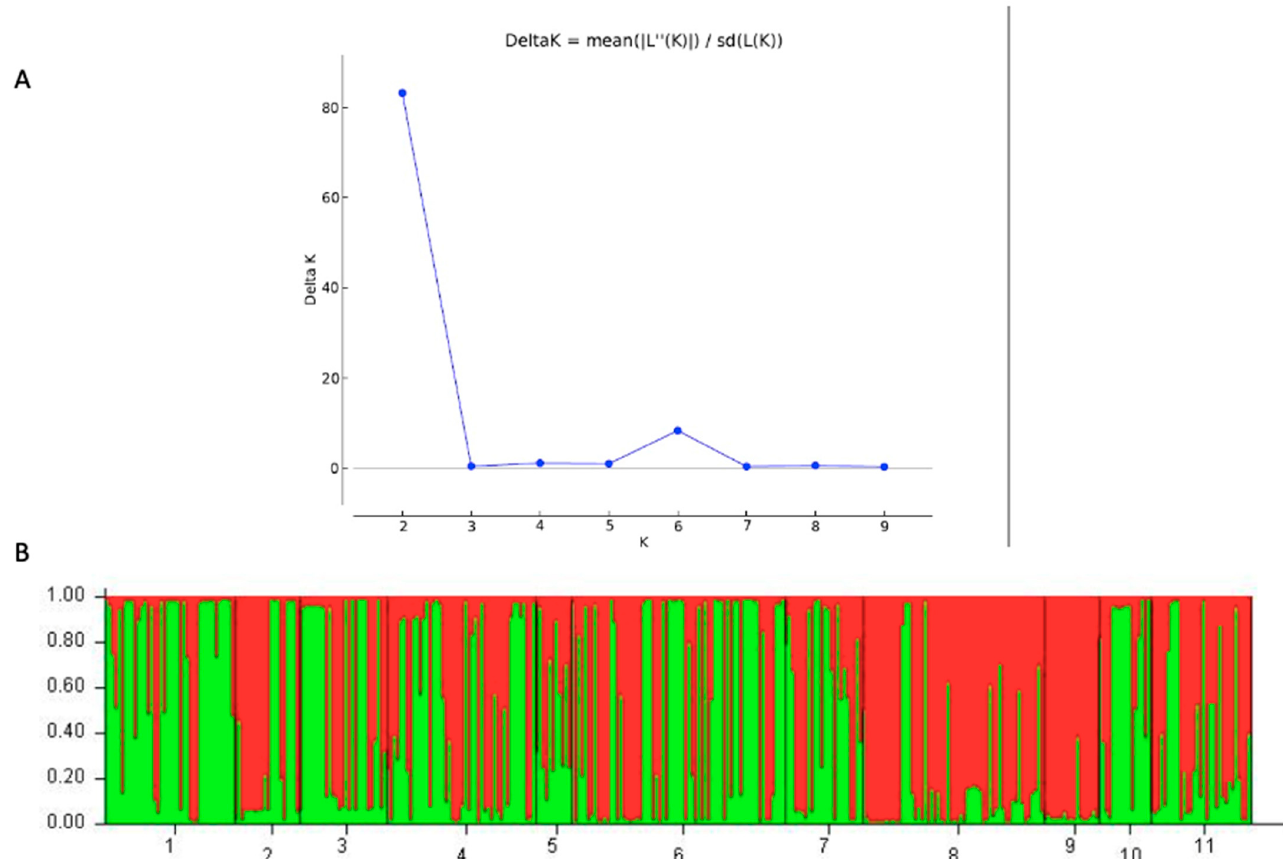
Figure 5. Results from STRUCTURE analyses of 354 isolates of F. commune causing root rot in strawberries in southcentral China. ( A ) shows evidence for optimal K value of 2. ( B ) shows the distribution of two genetic clusters among 11 local populations. The population labels of 1–11 on the X-axis correspond to GY, HN, HR, LF, LS, WL1, WL2, XX, YD1, YD2, and YJ, respectively.